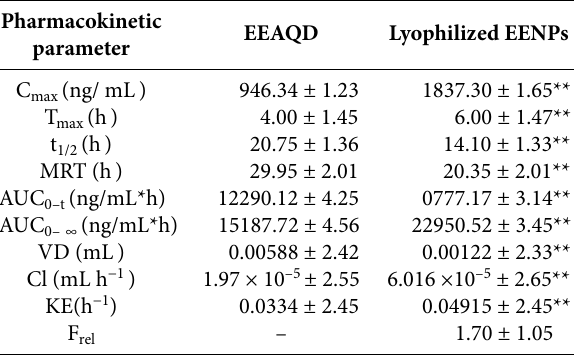
Table 11. Pharmacokinetic parameters of EEAQD and lyophilized EENPS in Sprague- Dawley rats.